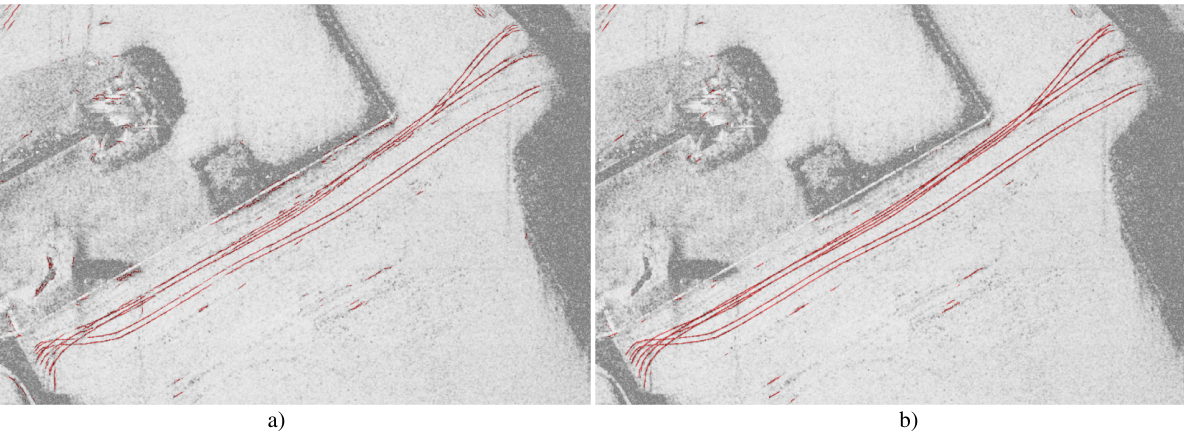
Figure 9. Segmentation of test area (Image C 6 ); a) augmented data set DS A − E , b) large un-augmented data set DS BigData . duces a DPR of 79.4% and an L max of 3663.2 pixels. Even